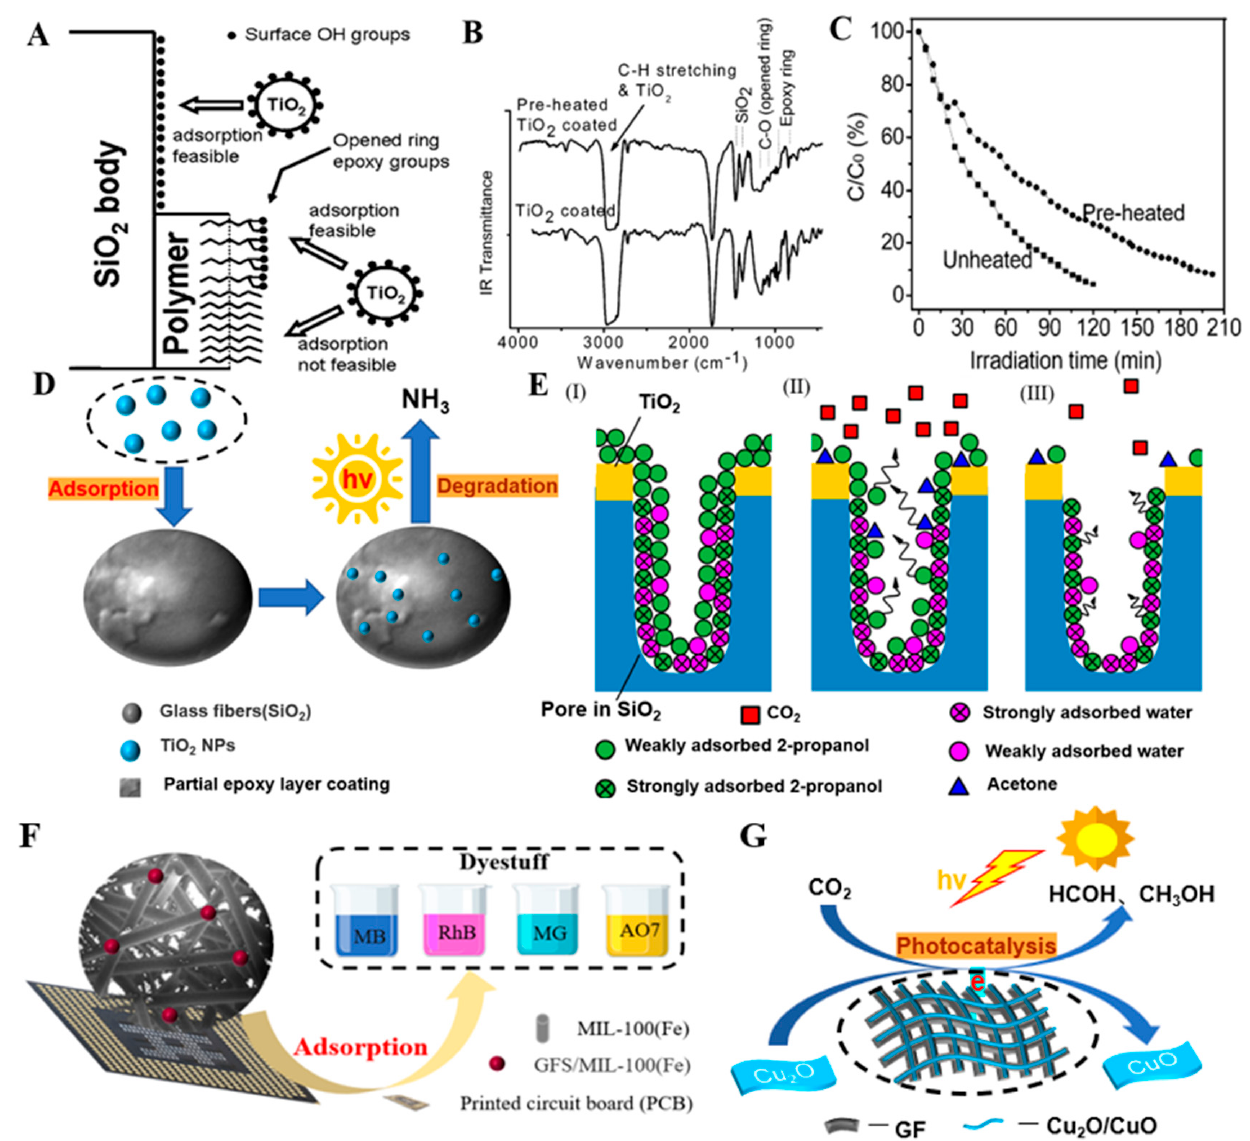
Figure 21. ( A ) Illustration of interactions between a TiO 2 nanoparticle in solution and the surface of SiO 2 , the opened ring epoxy groups, and the organic chains of the layer on the surface. ( B ) FT − IR spectra of the coated glass fibers with and without preheating at 500 °C. It can be seen that the peaks of the epoxy ring and C − O (due to opened rings) are reduced after heating. ( C ) Photocatalytic degradation of ammonia for preheated and unheated glass fibers coated with TiO 2 nanoparticles. Reproduced with permission from reference [82]. Copyright 2007 The Journal of Physical Chemistry C .